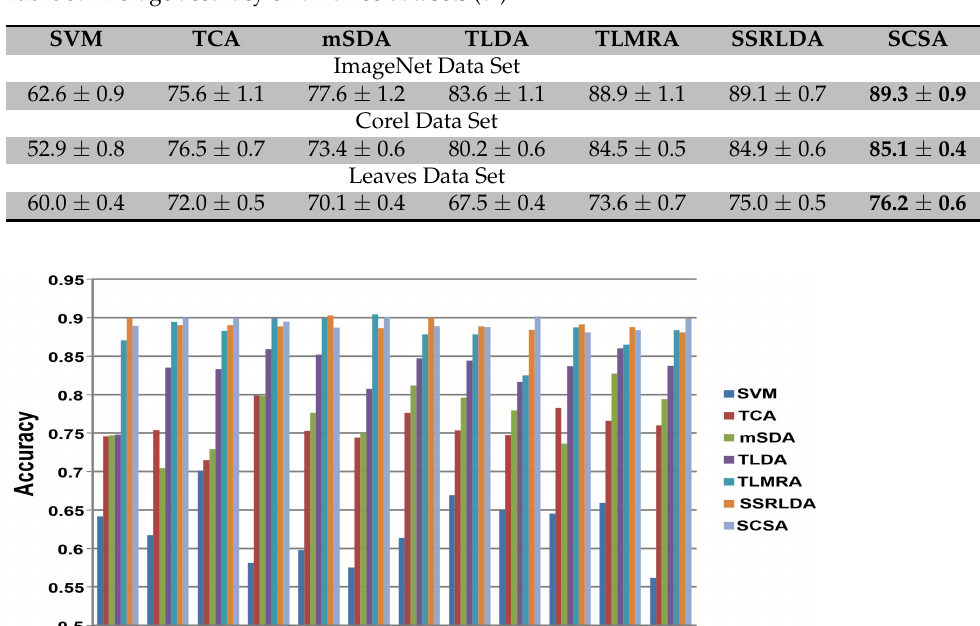
Table 3. Average accuracy on all three datasets (%).